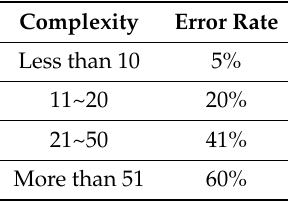
Table 1. Relationship between software complexity and error